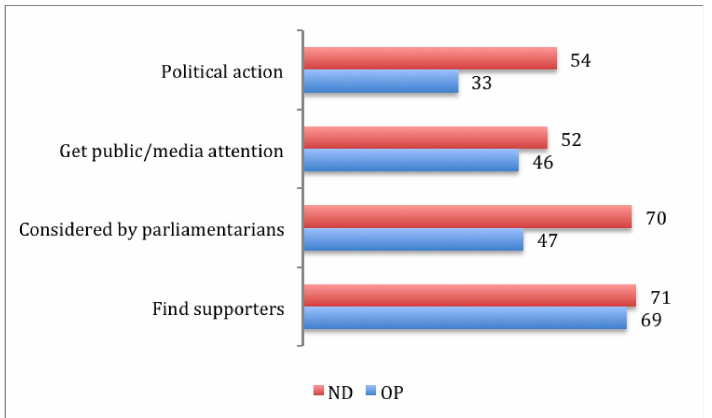
Figure 6. Expectations of ND and OP respondents (%) (Author’s surveys 2011) User expectations about feedback from their representatives is confirmed by the fact that an overwhelming majority of OP users (circa 80%) would be eager to communicate with and advance proposals to MPs (see Figure 7). These respondents are more numerous, and more strongly convinced, in comparison to those who would like tools to communicate with each other (74%). In short, project users have very strong expectations about the parliamentary response to their inputs and are eager to interact with MPs.